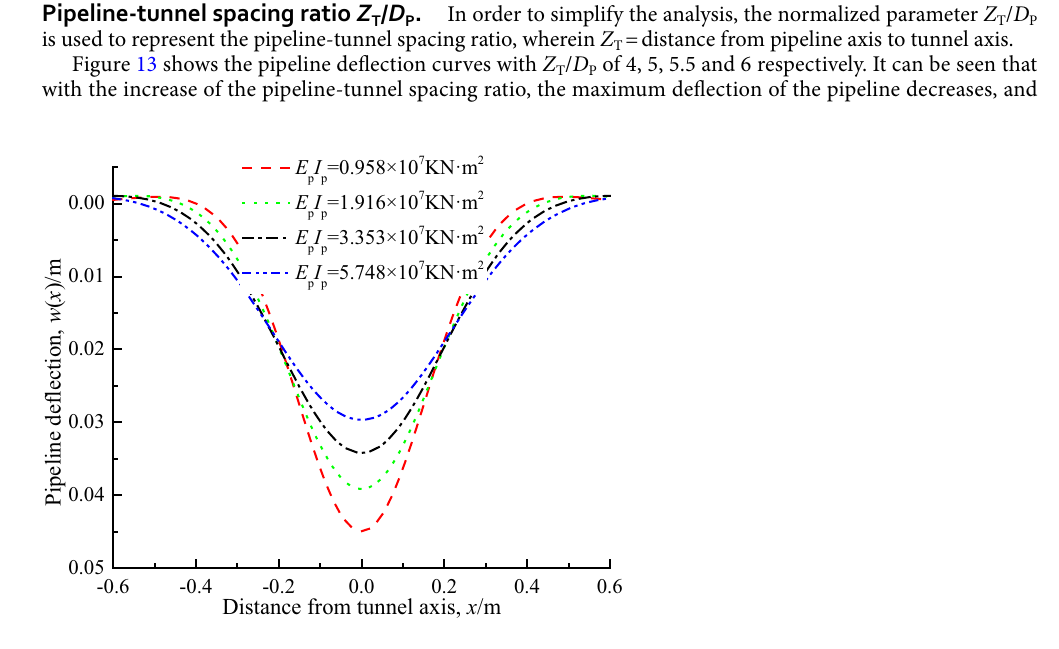
Figure 11. Pipe deflection under different pipeline